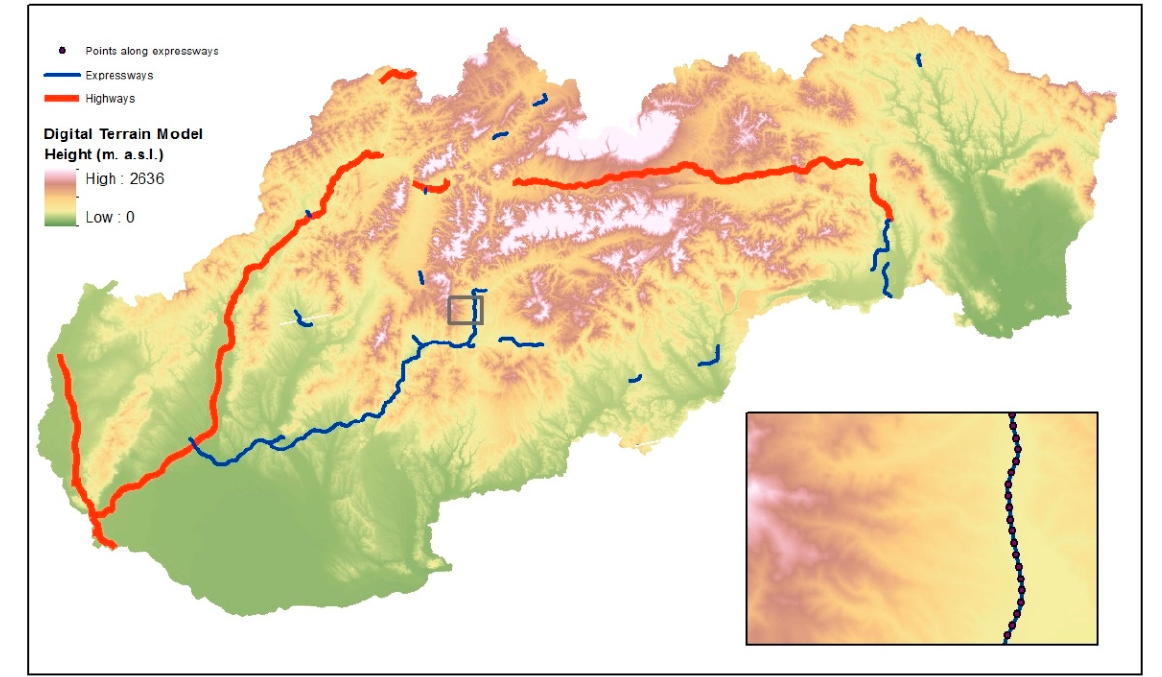
Figure 2. Selected major roads and DTM for the Slovak Republic.